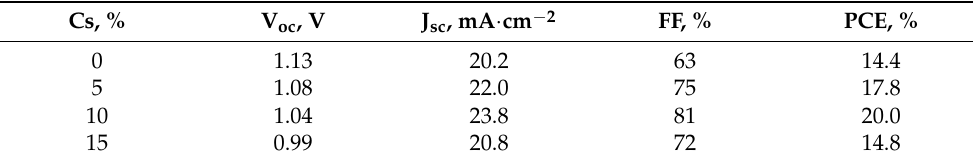
Table 2. Photovoltaic parameters of the perovskite solar cells with different cesium concentration. Cs, %